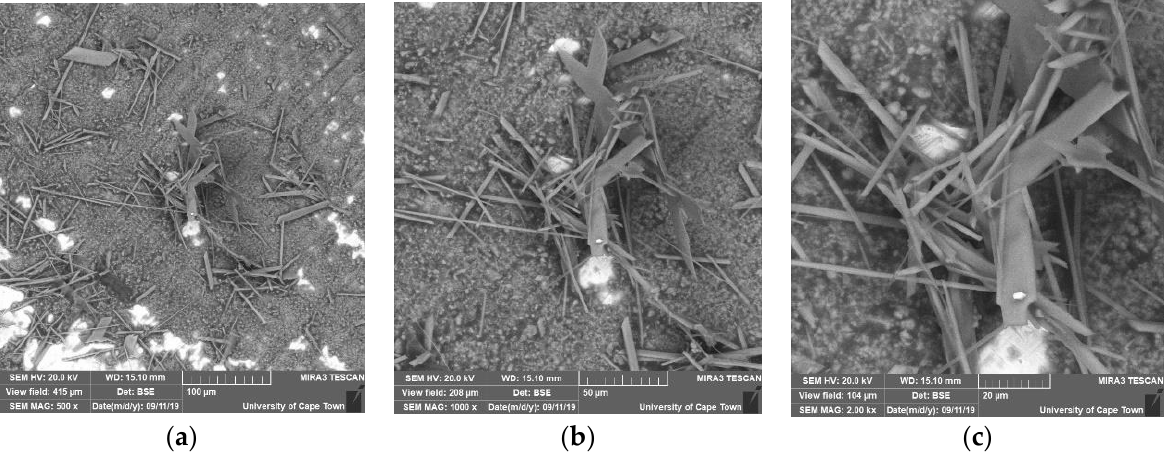
Figure 4. Micrographs of a scaled tube after running the experiment for 4 h. Scale bar = 100 µm ( a ), 50 µm ( b ) and 20 µm ( c ) respectively.